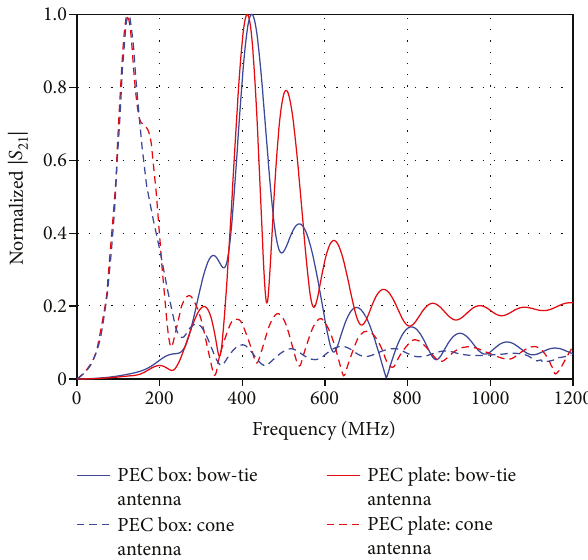
Figure 2: Frequency response without fi ltering the antenna e ff